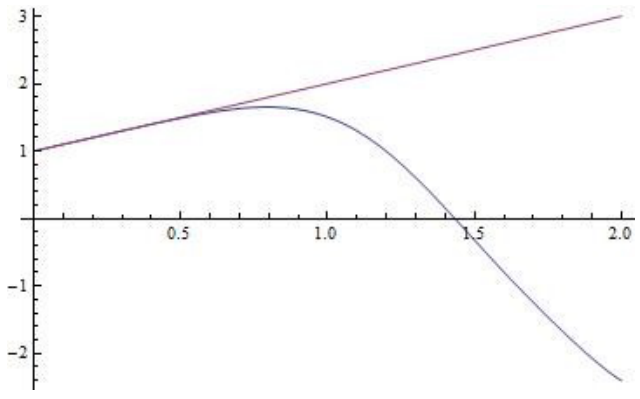
Fig. 7 Comparison graph of the solution for the interval [ 0 , 2 ] using AIM and exact solution.